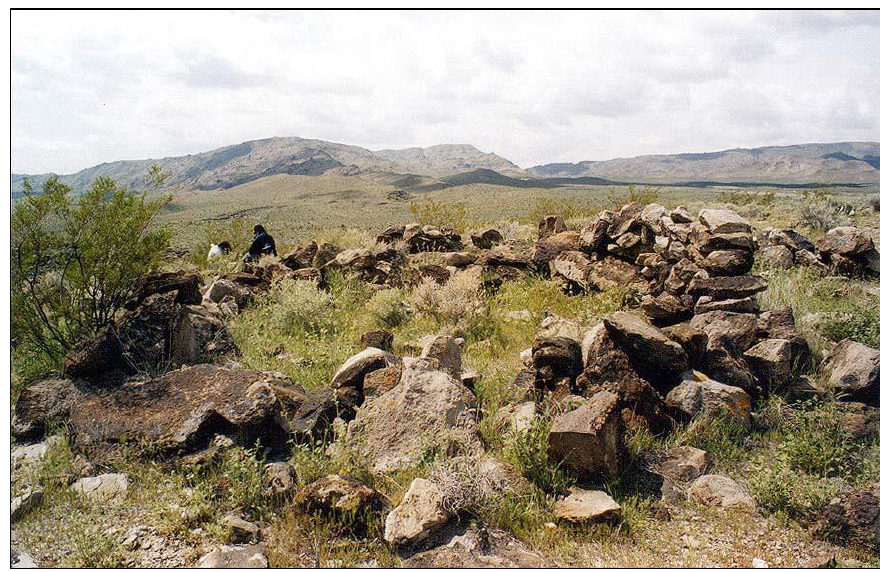
Figure 11. Circular stone walls on top of Black Butte with view to Southwest (Source: Stoffle). Plants are connected to this site through medicine, ceremony, and healing (Western